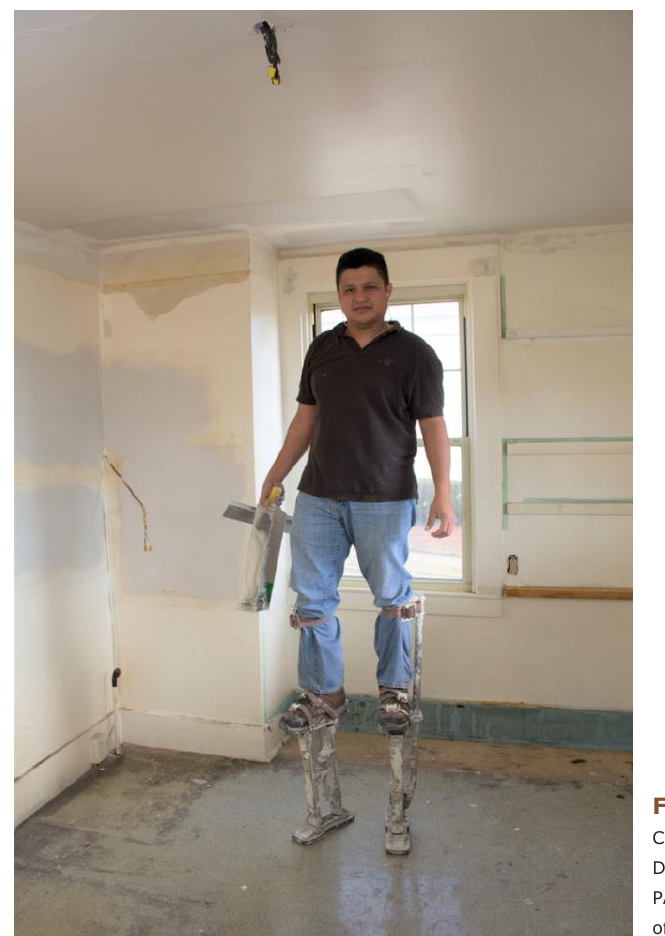
Carolina Genet, Self-made Stilts , Digital photograph, Pittsburgh, PA, December 5, 2016. Courtesy of Héctor Camilo Ruiz